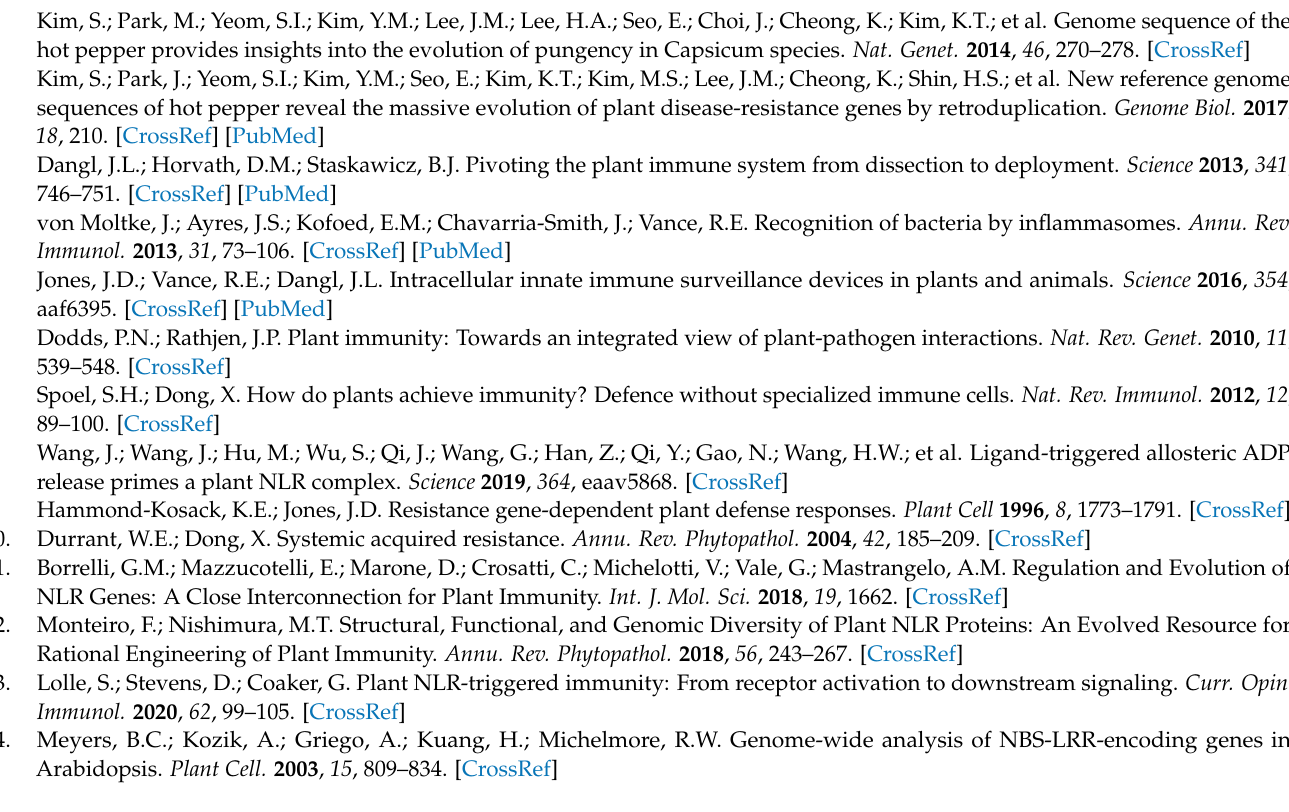
Figure S2: Expression analysis of PR1 and PR2 after C. acutatum inoculation, Figure S3. Analysis of the CbCN -silencing efficiency and disease resistance to C. capsici in CbCN knockdown chili pepper fruits, Table S1. List of primers used in this